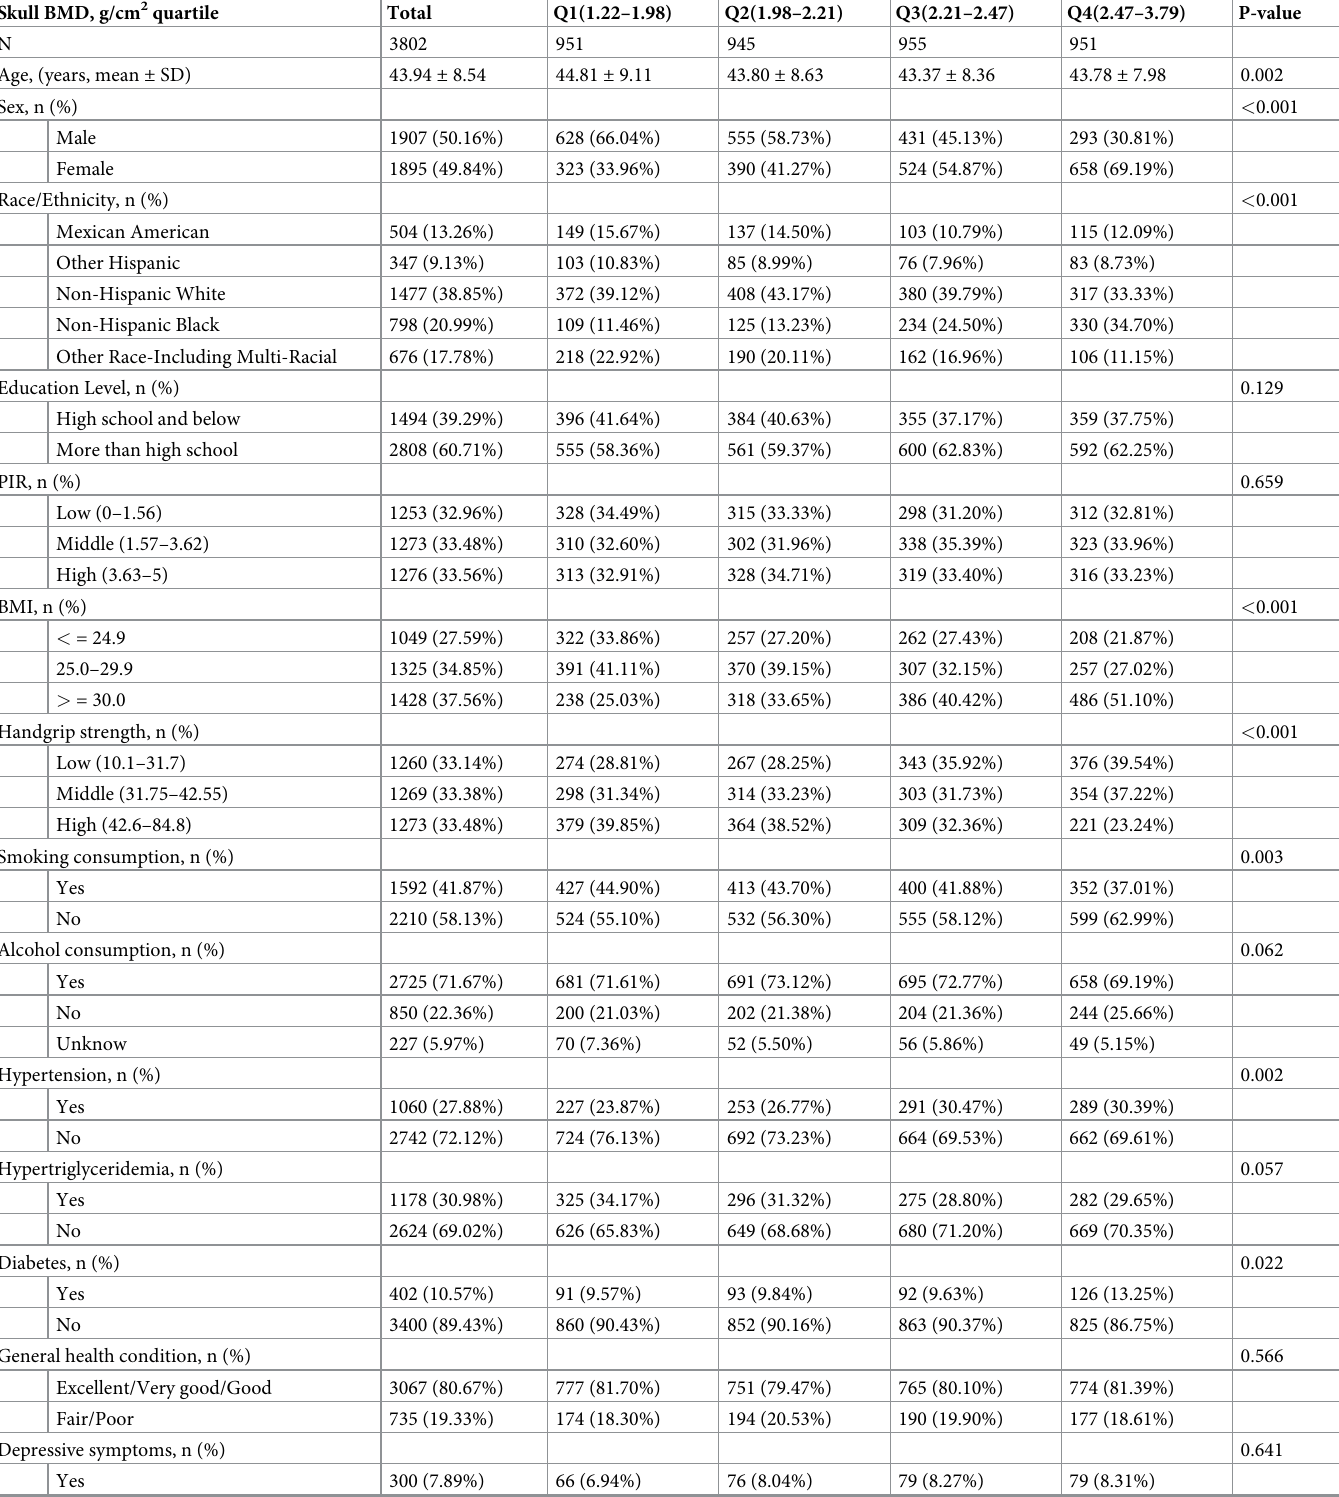
Table 1. Baseline characteristics of participants (N =